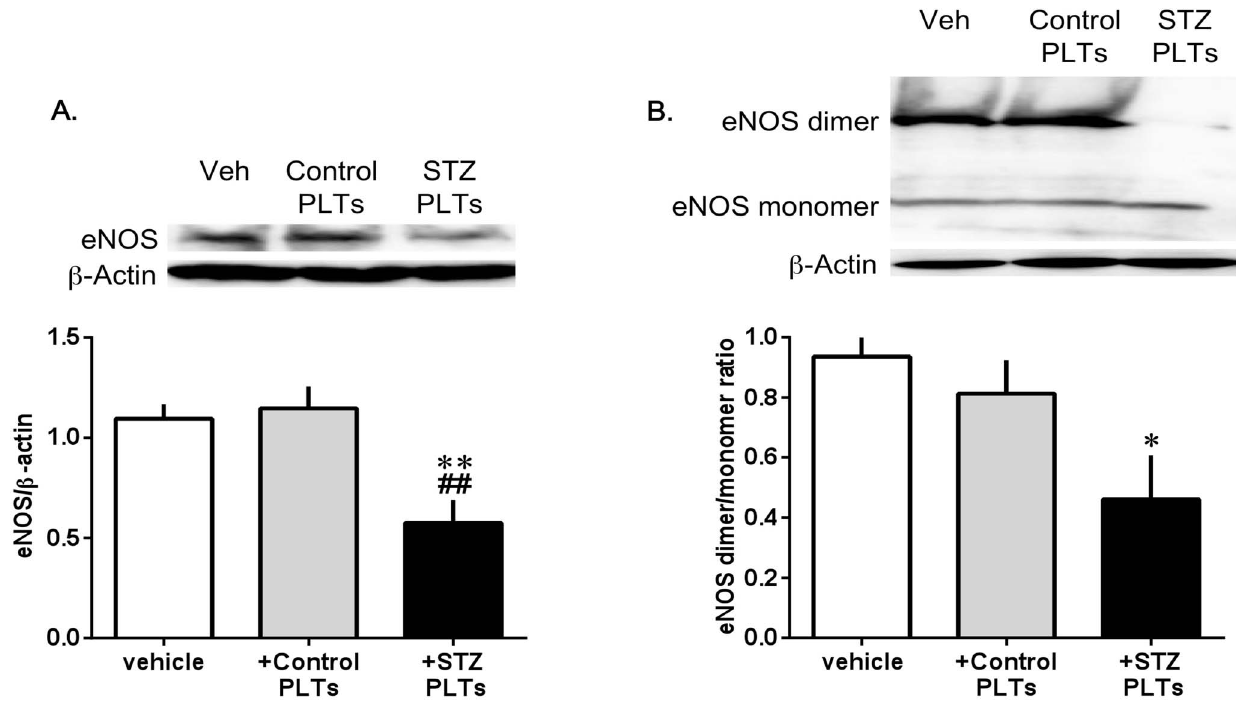
Figure 6. Total eNOS and eNOS dimers/monomers in HUVEC cultured under control PLTs or STZ PLTs stimulation. Western blots for eNOS expression (A) and eNOS dimer/monomer (B) in HUVECs cultured with PLTs (1.65 6 10 7 cells/mL; 30 min) isolated from control or diabetic rats. Data are means 6 SE; n=6; * P , 0.05, ** P , 0.01 vs. vehicle, ## P , 0.01 vs. + Control PLTs.